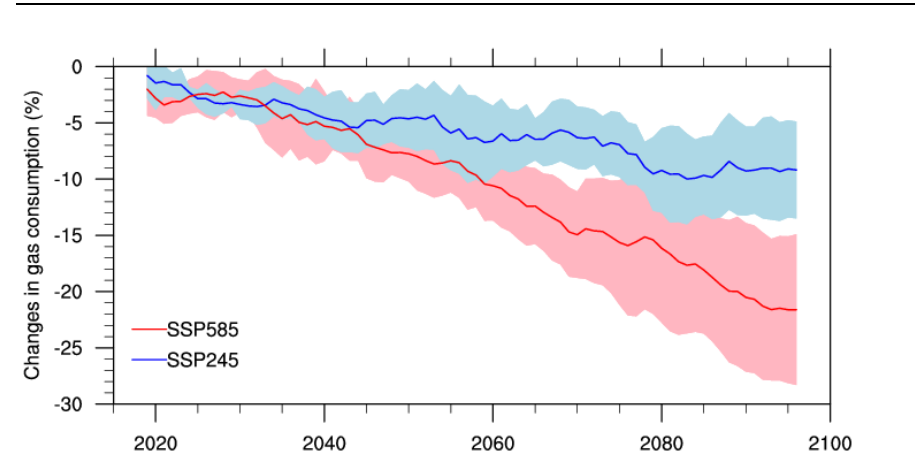
Figure 5. Percentage changes in the 9 year smoothed natural gas consumption with respect to tem- perature changes under the SSP245 (blue line) and SSP585 (red line) scenarios during heating season for the period of 2015–2100 (relative to 1995–2014) in Beijing. Shadings denote the model spread.